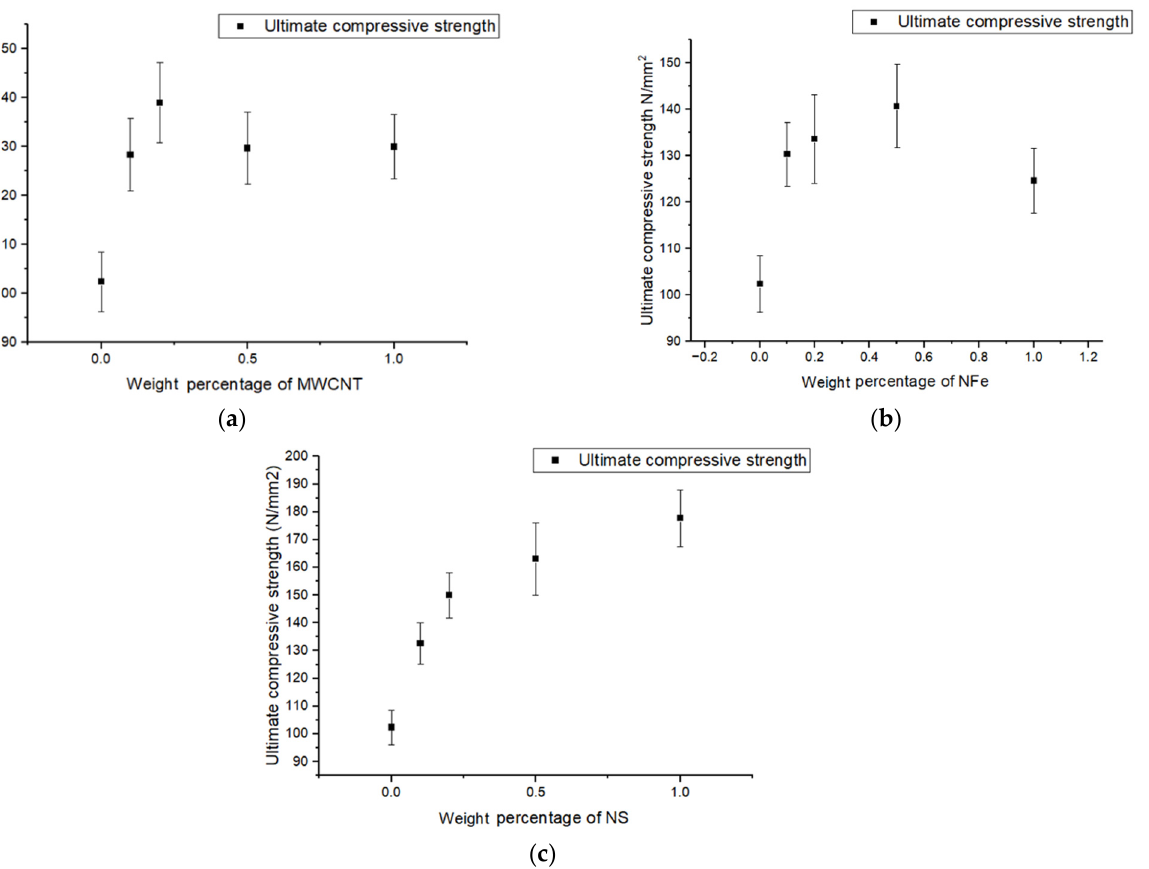
Figure 5. Variation in ultimate compressive strength of modified GFRP samples with different weight percentages of ( a ) MWCNTs, ( b ) NFe, and ( c ) NS.